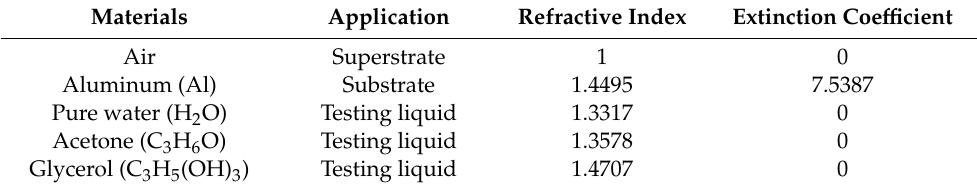
Table 4. Optical properties of the materials used in calculations.